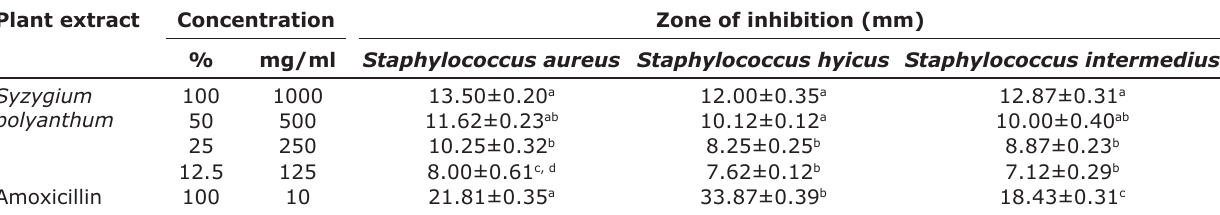
Value represent mean±SEM (n=4). Means with different alphabets indicate significant differences among different concentrations Table-5: MIC and MBC of plant extract against Staphylococcus aureus , Staphylococcus hyicus, and Staphylococcus intermedius . Plant extract